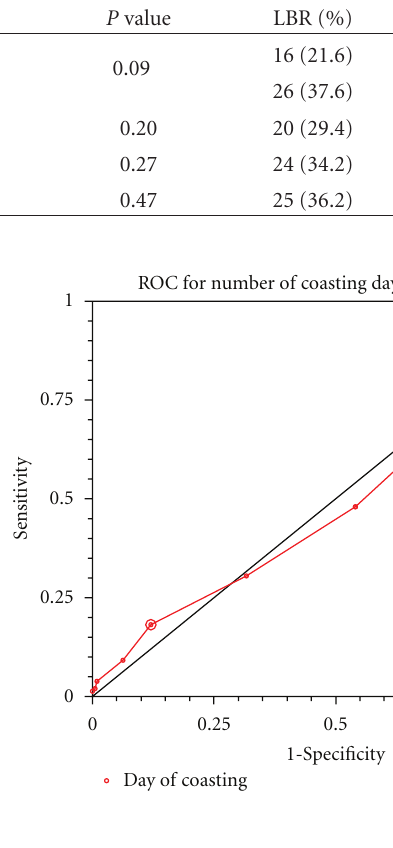
Figure 2: Live births (LB): optimum cut-o ff FSH value: 5.6; sensitivity: 78%; specificity: 27; ROC area under curve (AUC): 0.50 (95% CI: 0.70 to 0.85). Clinical pregnancies (CP): Optimum cut-o ff FSH value: 5.6; sensitivity: 80%; specificity 30%; ROC area under curve (AUC): 0.53 (95% CI: 0.73 to 0.85).